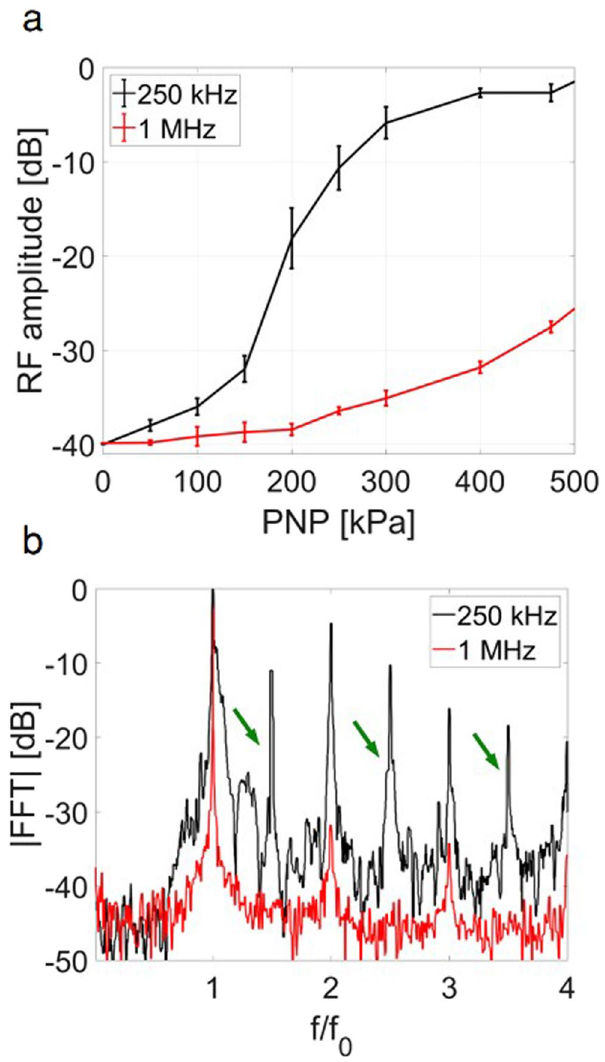
Figure 6. Passive cavitation detection. ( a ) RF amplitude of the second harmonic as a function of the peak negative pressure (PNP). Ultraharmonic components at 250 kHz insonation are indicated by the green arrows ( b ) Magnitude of the received echo spectrum following excitation of the MBs as a function of normalized frequency using 400 kPa and a center frequency of 250 kHz (black), and 1 MHz